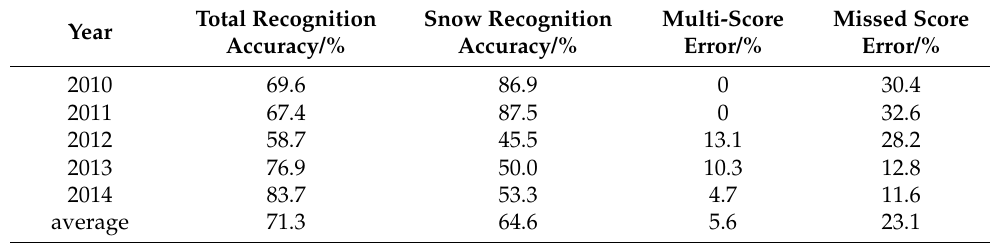
Table 1. Accuracy of the MOD10A2 image for snow recognition in the upstream region of the Shule River